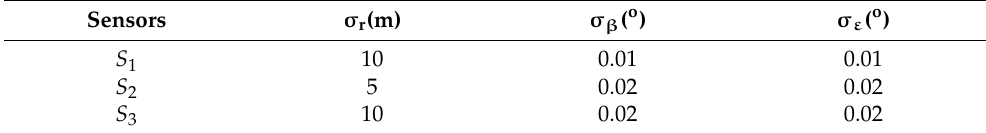
Table 4. Measurement accuracy of multiple sensors.